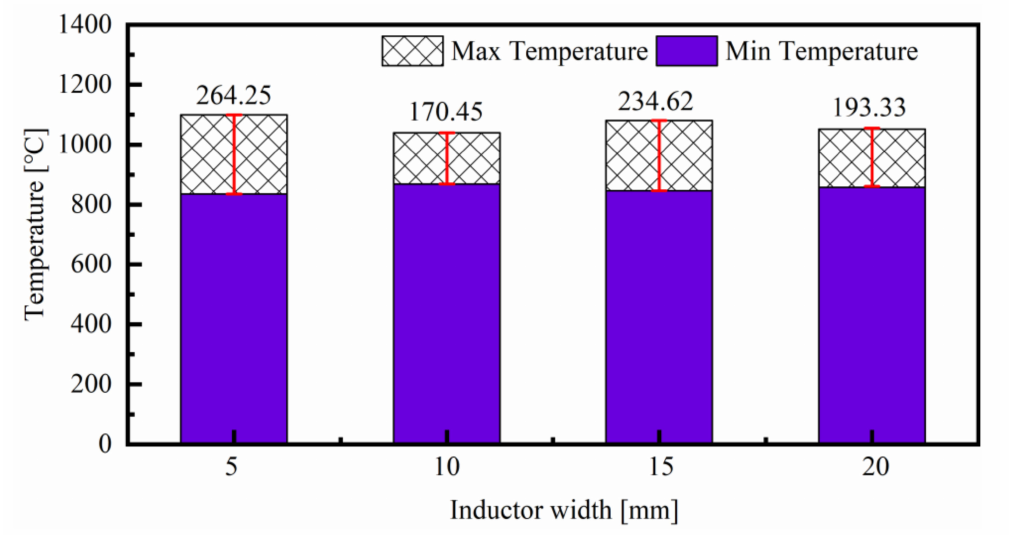
Figure 14. The temperature difference of a rectangular steel tube based on inductor with different widths.